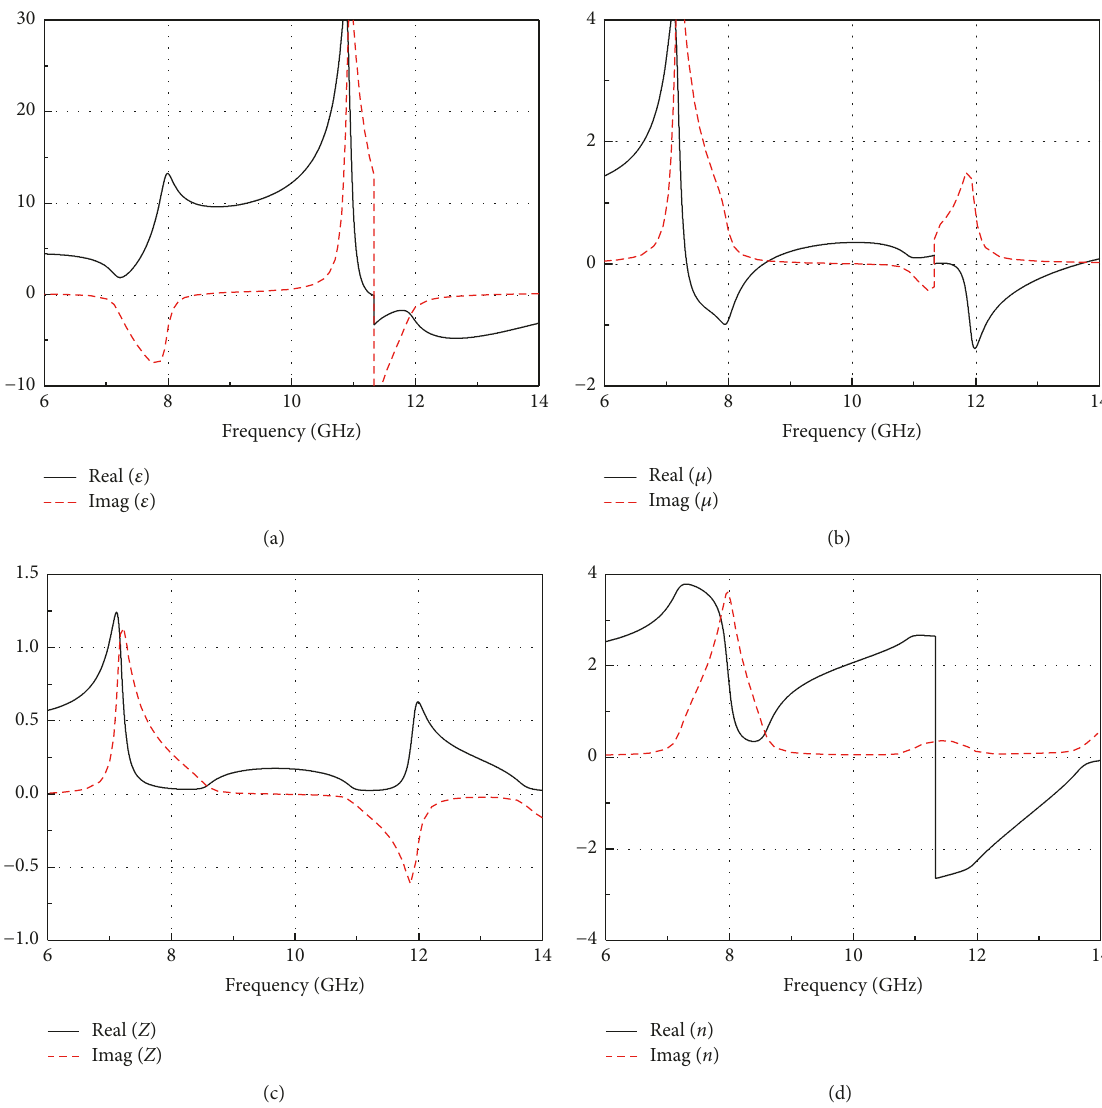
Figure 9: Retrieved effective (a) permittivity “ 𝜀 ,” (b) permeability “ 𝜇 ,” (c) impedance “ 𝑍 ,” and (d) refractive index “ 𝑛 .” The black solid lines refer to the real part of these parameters, while the red dashed lines refer to the imaginary part.